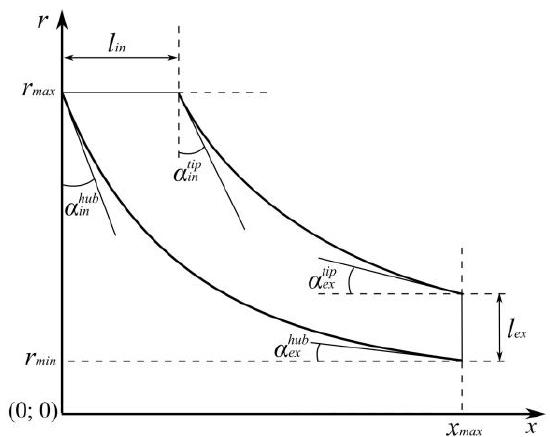
edge and angle α at the trailing edge. The angle α is 2 p 2 p found from the range between α and α so as to assure 2 s 2 ef the minimum curvature of the pressure curve (Fig. 2) or